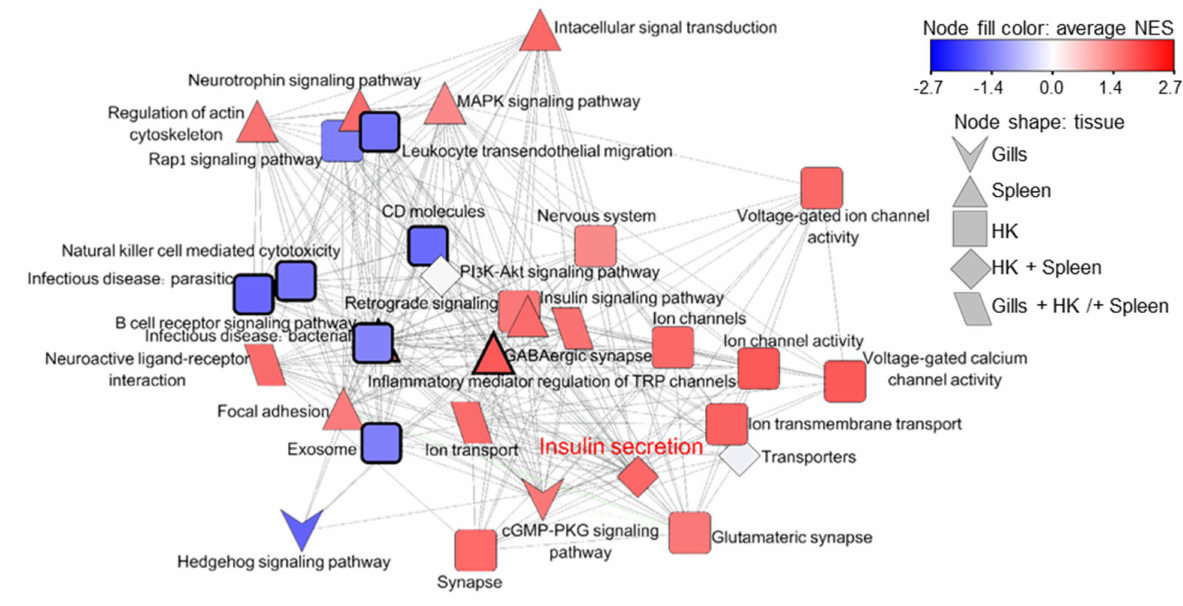
Figure 5. Insulin secretion network analysis for enriched GO and KEGG pathways. Enriched processes from gills, spleen, and HK were organized into a network based on shared genes. Edge lengths are derived from common genes between the connected nodes. Network presents processes that are first neighbors to insulin secretion (labeled in red). Node fill is color-scaled according to mean NES (up-regulated in red, down-regulated in blue), and node shape indicates the tissue, as legend details. Processes that are related to the immune system are with thicker node border. See Supplementary Table S5 for additional details of the